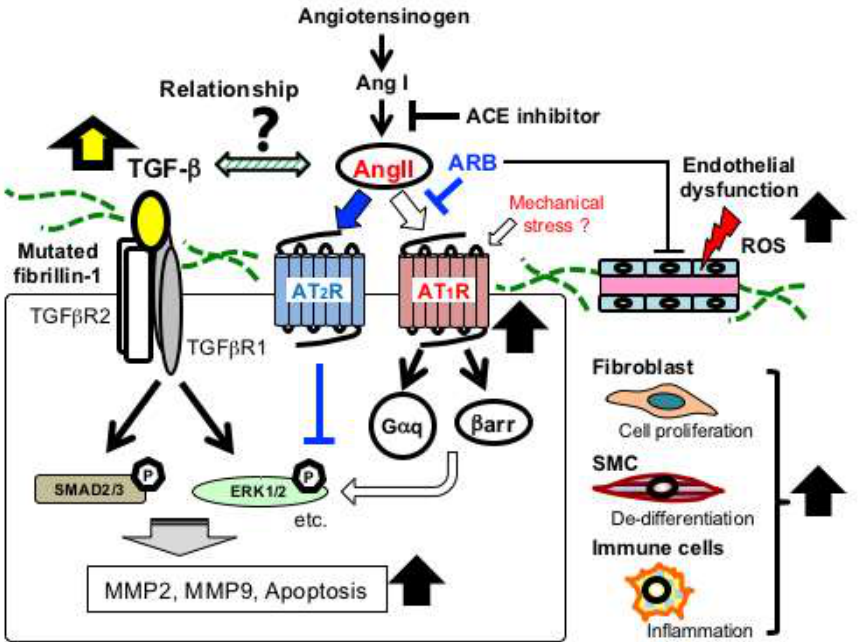
Figure 3. Schematic of major signaling pathways implicated in aortic aneurysmal formation in MFS. FBN1 mutations have been considered to mainly cause impaired smooth muscle cells